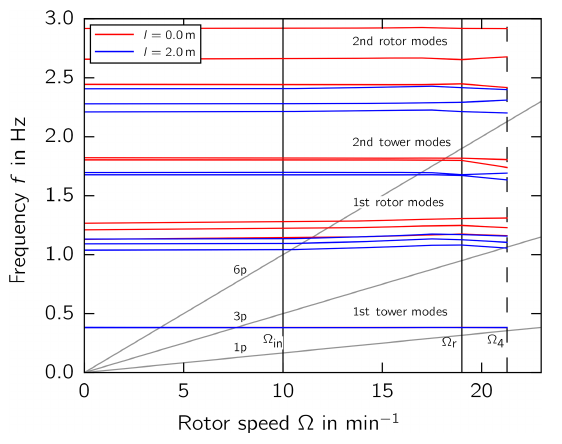
Figure 11. Campbell diagrams for the original turbine and the tur- bine with an